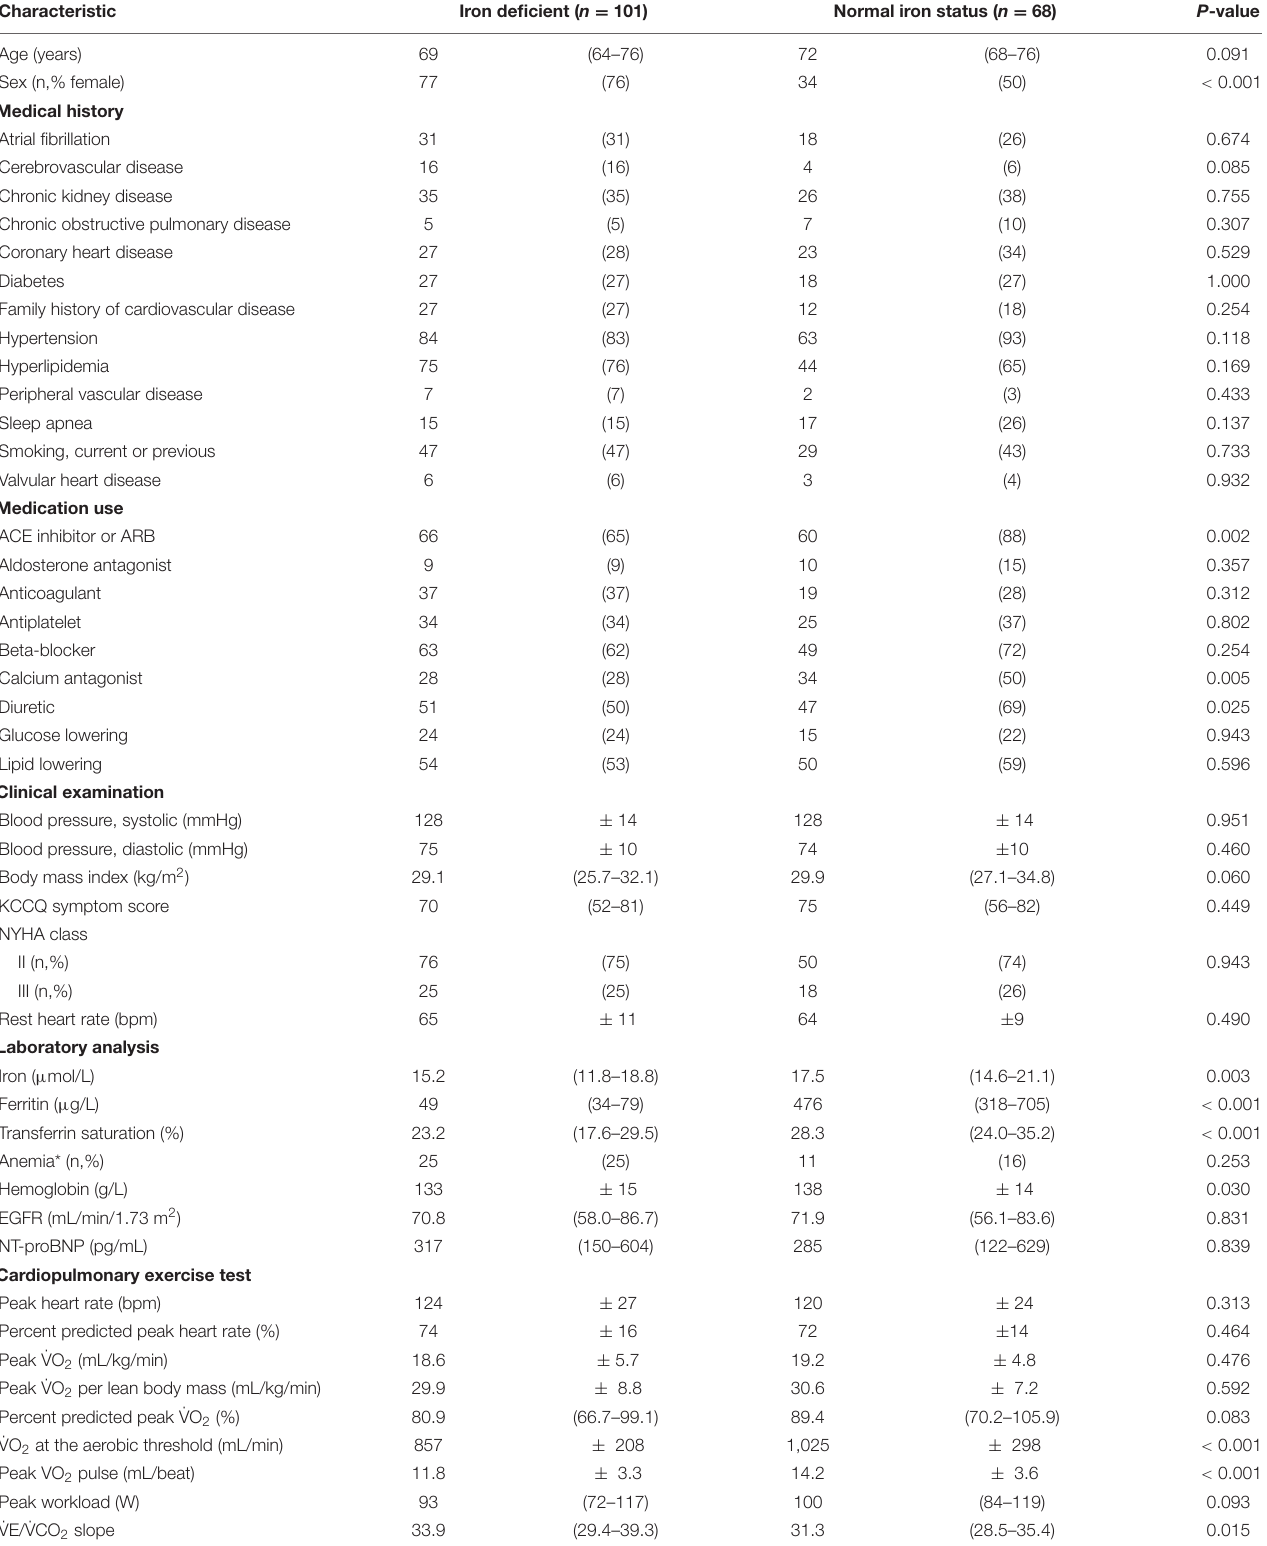
TABLE 1 | Characteristics of the study population, stratified according to the presence of iron deficiency.